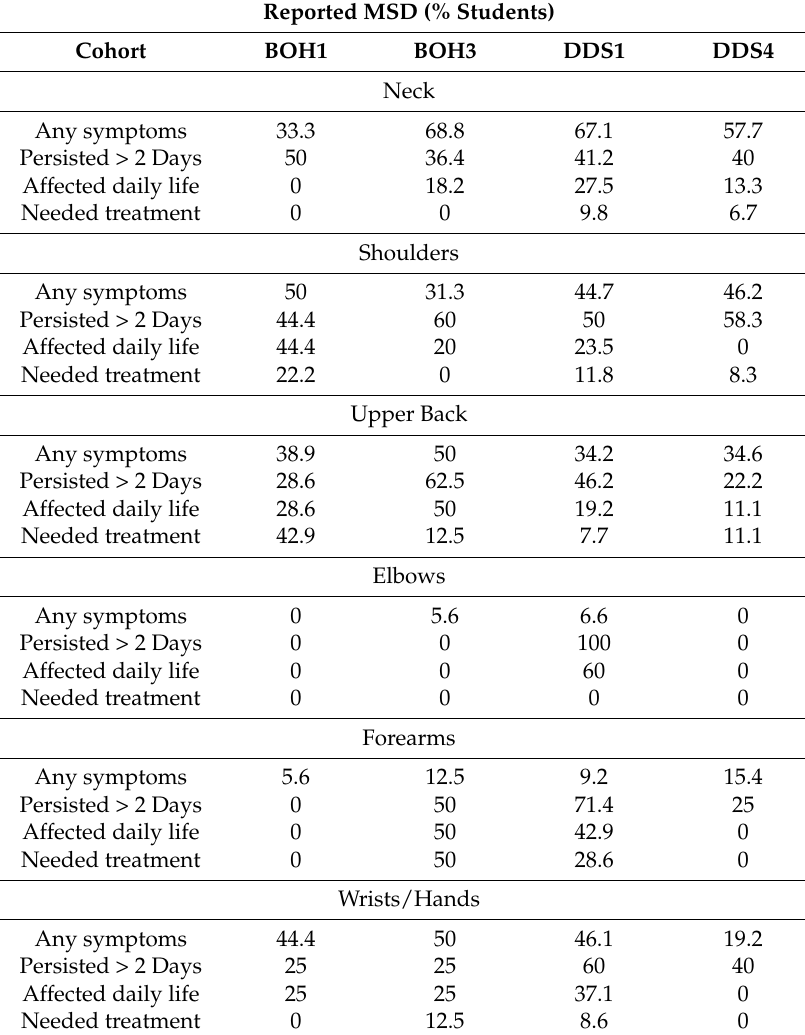
Table 4. Prevalence of MSD by upper body